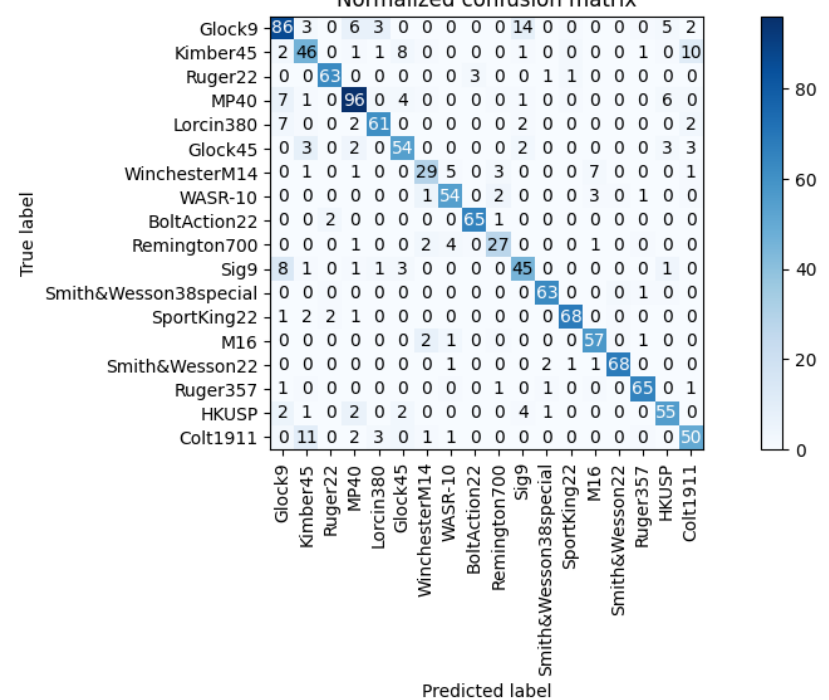
Figure 12. Confusion matrix diagram for the gunshot dataset.